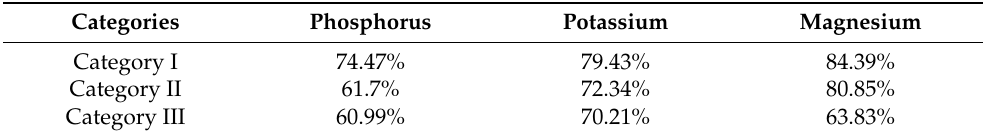
Table 5. Prediction results corresponding to the Global soil dataset analysis for different categories using the DT method.